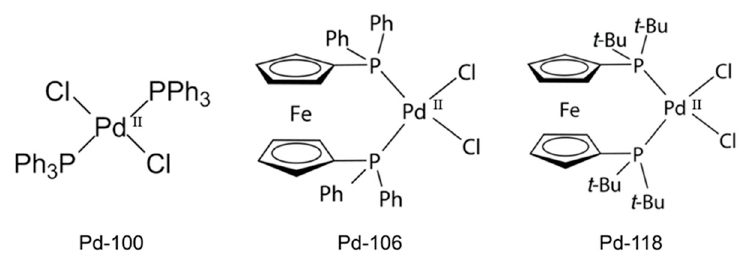
Figure 6. Homogeneous catalysts: Pd-100, Pd-106 and Pd-118 [41].